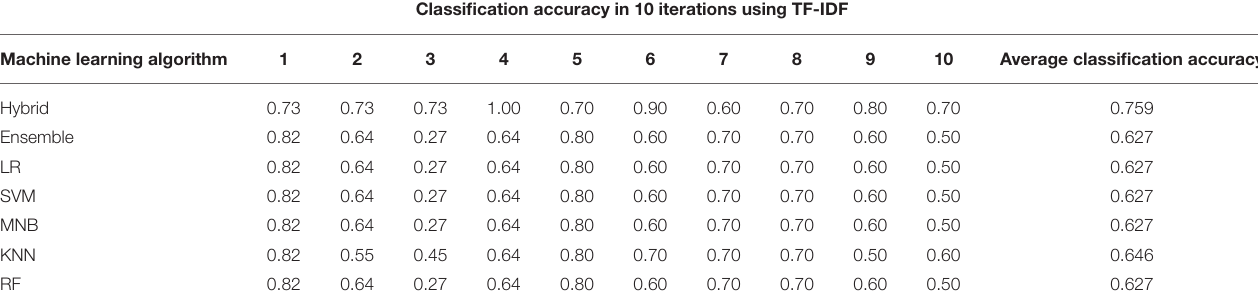
TABLE 7 | Classification accuracy of ML algorithms for IoT oriented healthcare